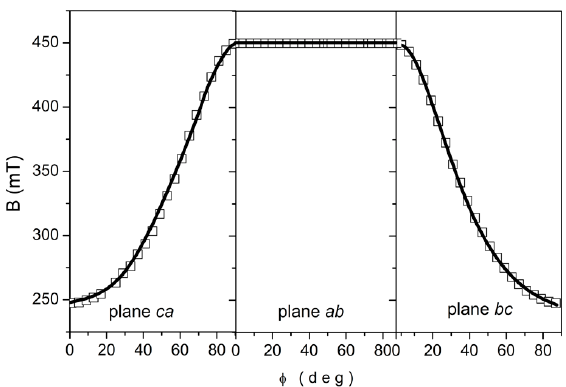
Figure 5. The angular dependencies of resonance line positions of the main center measured when crystal (BaWO 4 : Ce 3+ 0.5%) is rotating perpendicularly to a , b , and c laboratory axis at a temperature of ~8 K. Table 1. Hamiltonian parameters of Ce 3+ ions in the BaWO 4 crystal.